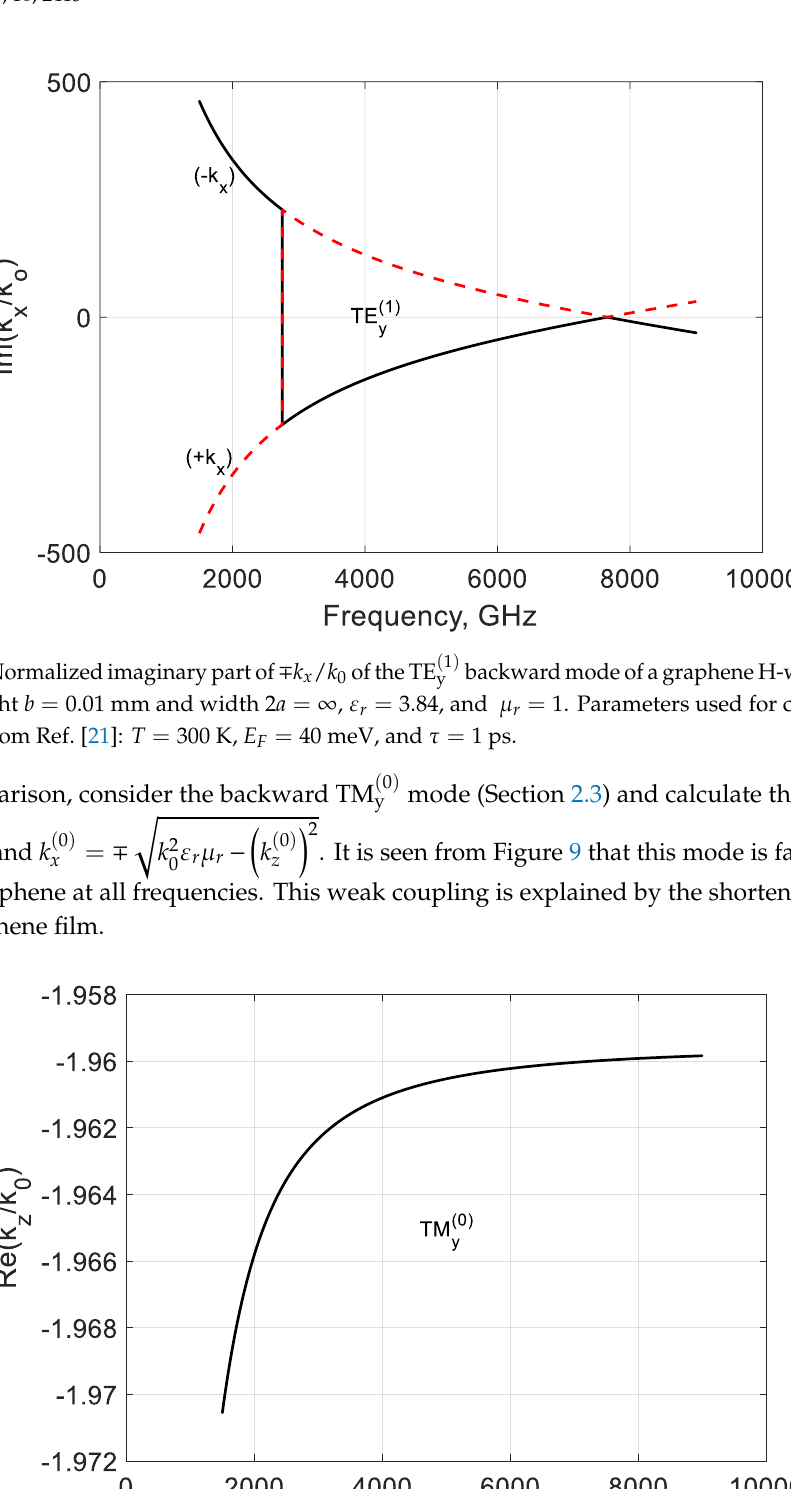
Figure 9. Normalized real part of the modal propagation constants 0 0 z k k of the first 0 y TM backward mode of a graphene H-waveguide of the height b = 0.01 mm, width 2 a = ∞ , ε r = 3.84 , and µ r = 1. Parameters used for calculation of σ g are from Ref. [21]: T = 300 K, E F = 40 meV, and τ = 1